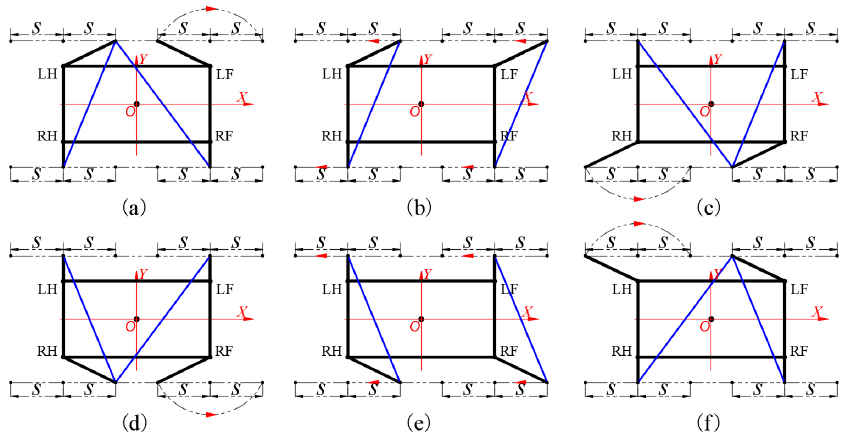
Figure 10. The relative position of the body and the ends of the four legs in the intermittent gait. ( a ) the LF has moved to the limit position, ( b ) the LF drops the ground, ( c ) the moving of LF, ( d ) the moving of RF, ( e ) the moving of RH and RF, ( f ) the moving of LF and LH.